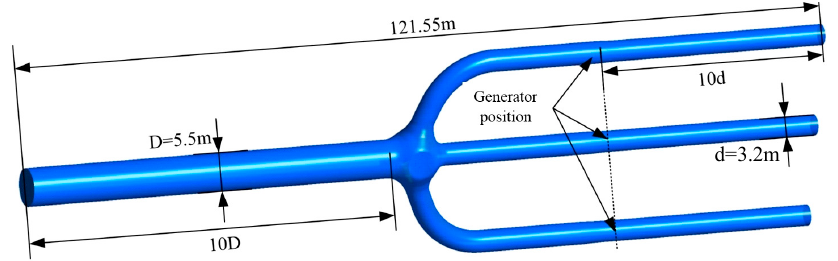
Figure 3. The geometry of the original model and the computational domain.